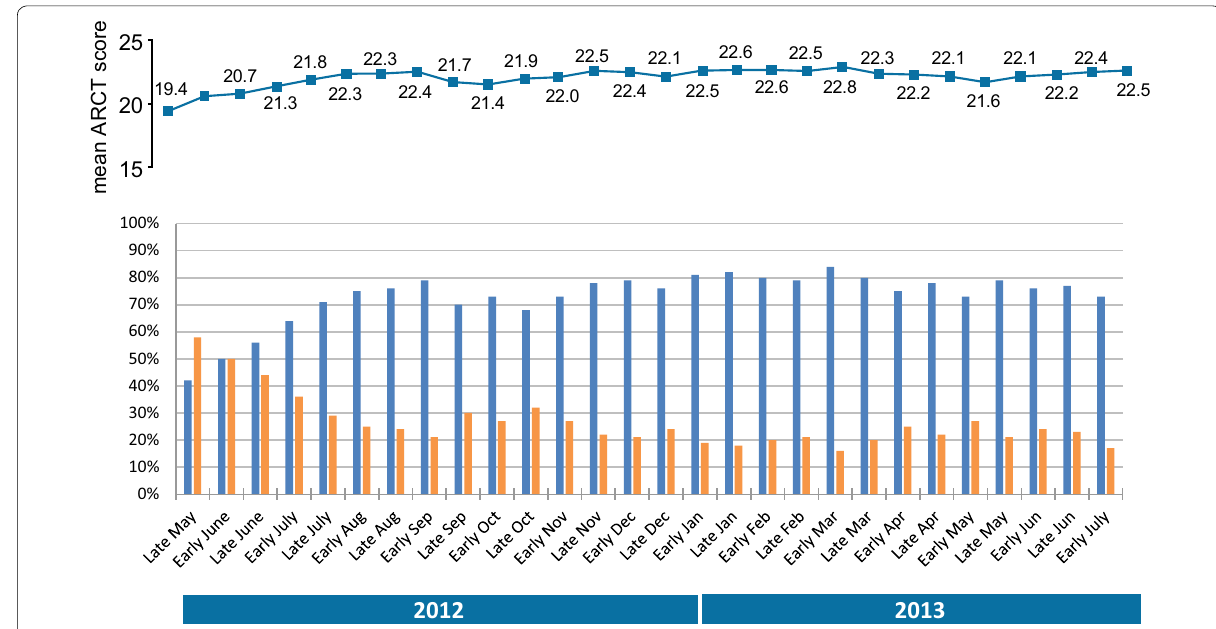
Fig. 6 Fortnightly telephone interviews of study participants: mean ARCT score (top panel) and percentage of patients with controlled/ uncontrolled disease (bottom